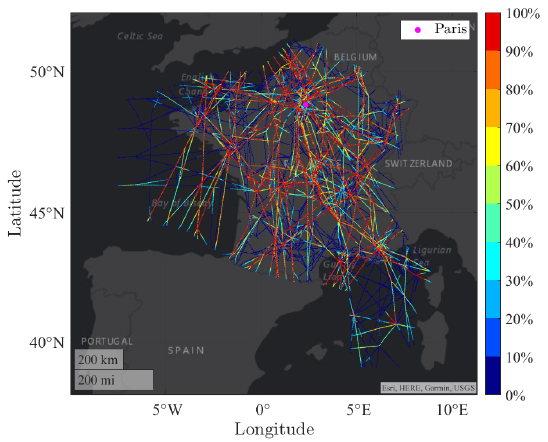
Figure 17. Traffic complexity of a traffic sample over French airspace. For each 4D point (x,y,z,t) of each trajectory, the complexity metric is computed and represented with a color map on a two dimension map